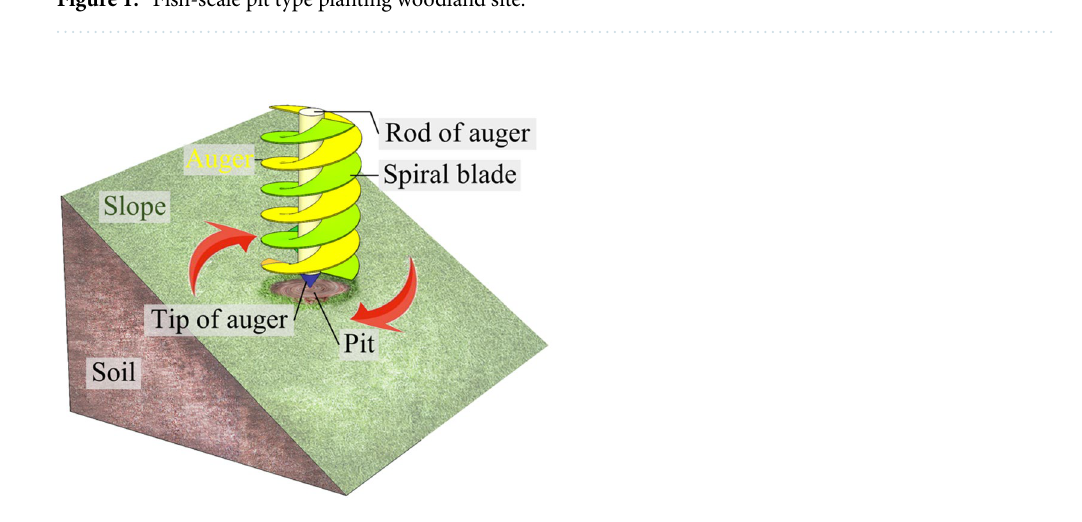
Figure 2. Model of auger working on